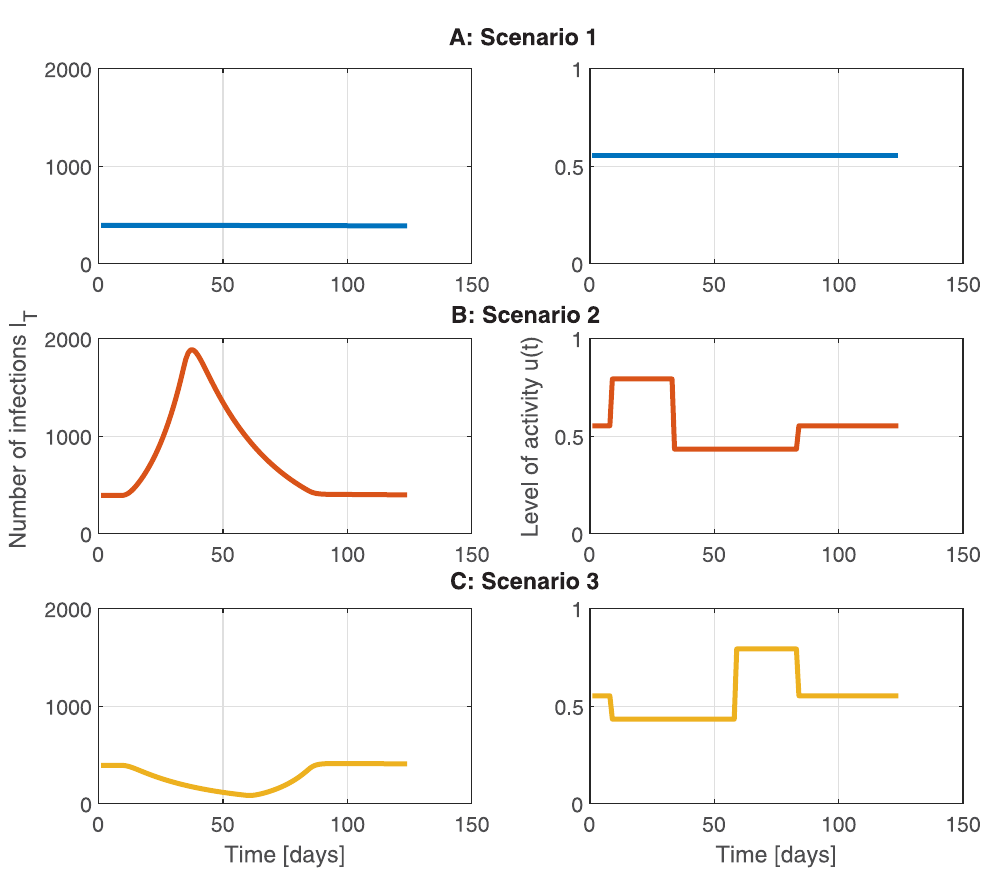
Fig 4. Pandemic sensitivity to interventions: Here we compare three approaches to pandemic control, holding all else equal (the cumulative interventions and the initial case rates, leading to the same final case rate). In the first scenario, interventions that lead to zero growth from the initial I T = 400 are maintained, leading to a cumulative infection case count R of I T ( t ) dt of 48516. In the second scenario, restrictions are initially relaxed, leading to pandemic growth. Tighter restrictions are then implemented to return to the initial number of infections I , leading to almost twice the number of R T total infections: I T ( t ) dt = 95174, illustrating the cost of delayed action. The third scenario starts by implementing stricter R interventions followed by relaxation, resulting in I T ( t ) dt = 34821, a reduction of 28% from the first scenario despite the same average level of restrictions.